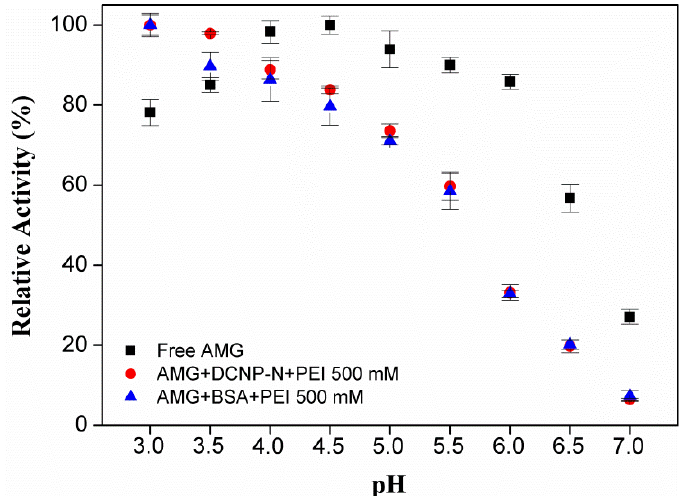
Figure 12. Effect of pH on the activity of free amyloglucosidase (AMG) and AMG CLEAs prepared by enzyme treatment with polyethyleneimine (PEI) and by co-aggregation with the magnetic nanoparticles DCNP-N or bovine serum albumin (BSA). Activity assay conditions: 1% ( w / v ) dextrin solution in 50 mM buffer, 10 min reaction at 55 °C under 900 rpm stirring. Values are shown as the mean of triplicate experiments ± s.d.